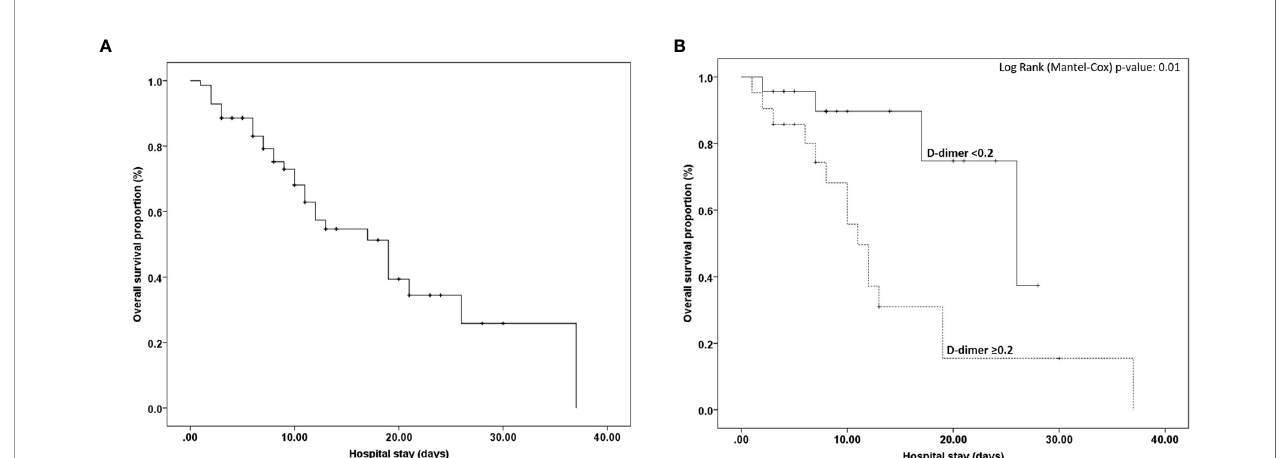
FIGURE 1 | (A) Overall Survival of COVID-19 cancer patients (B) Overall Survival of COVID-19 cancer patients strati fi ed by two groups of D-dimer (<0.2 and ≥